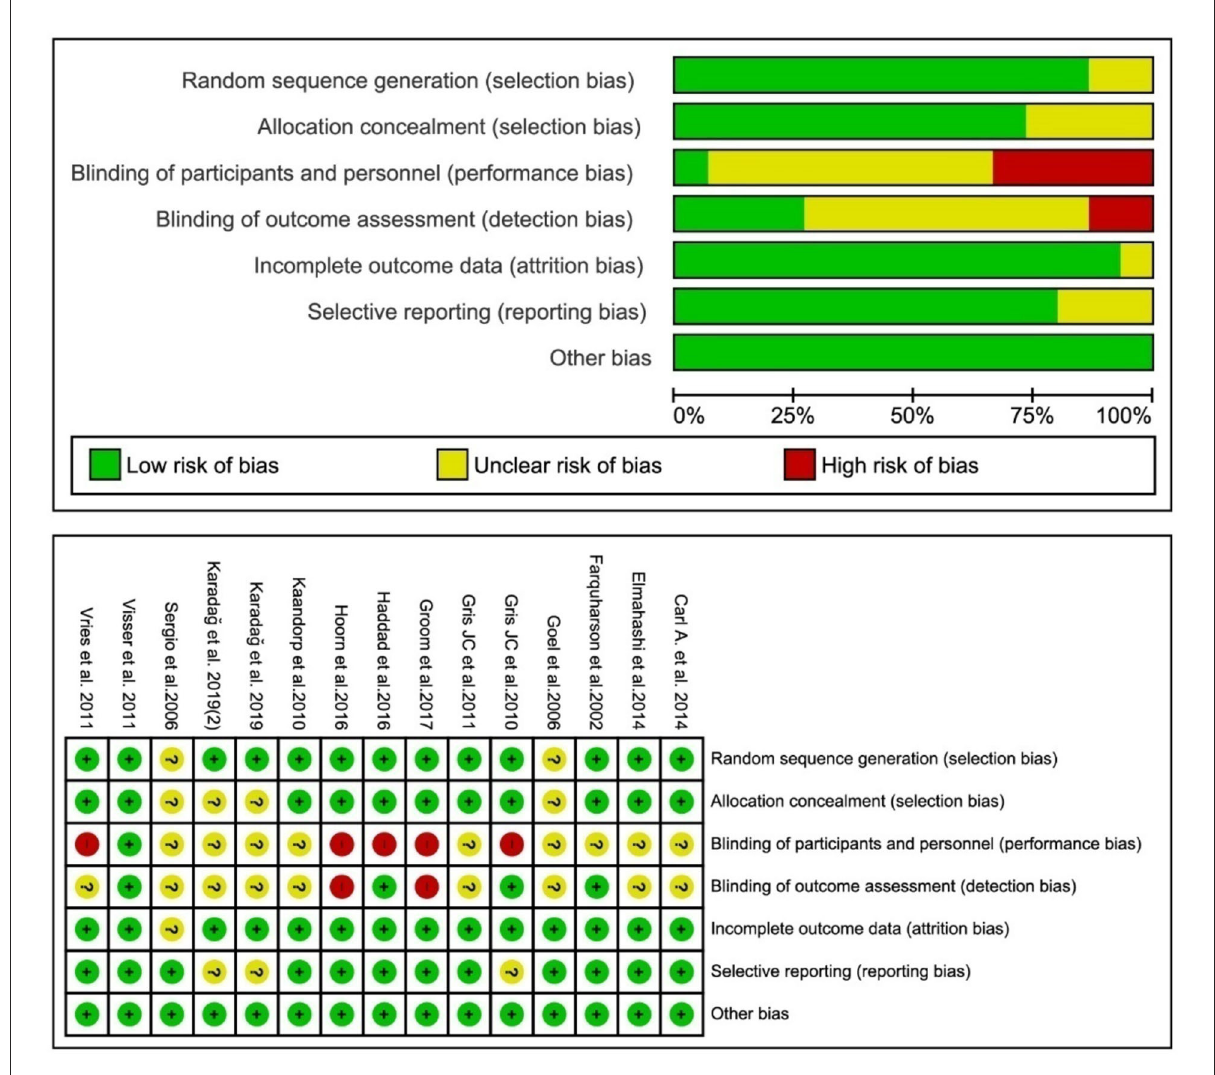
FIGURE2 Risk of bias assessment of the